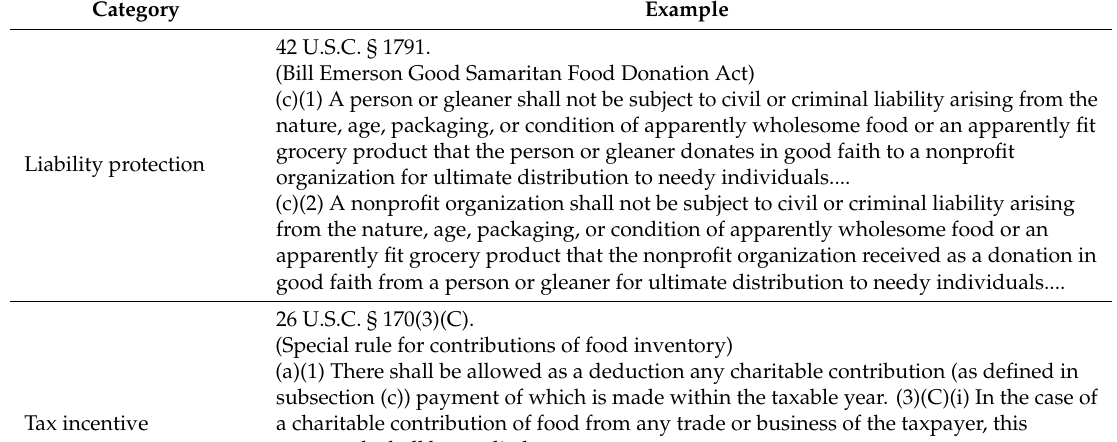
Table 1. Policy categories and example